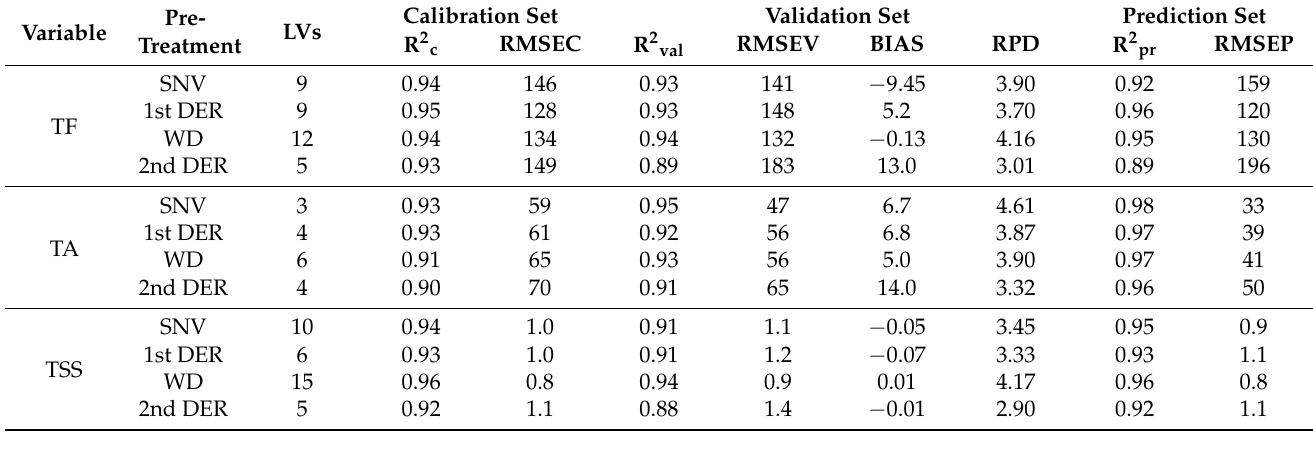
Table 2. Performance of partial least square (PLS) models depending on data pre-treatments for predicting TF, TA, and SSC,